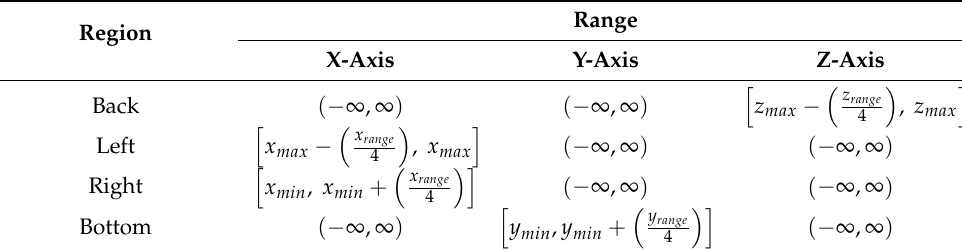
Table 1. Ranges for each local